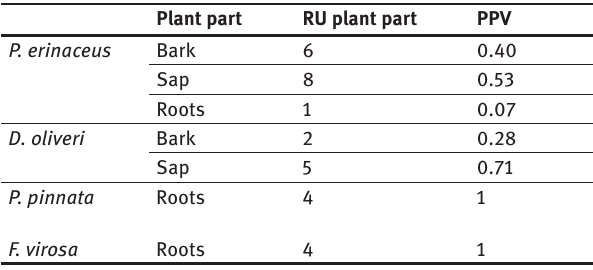
Table 2: RU and PPV of most valuable plants parts.